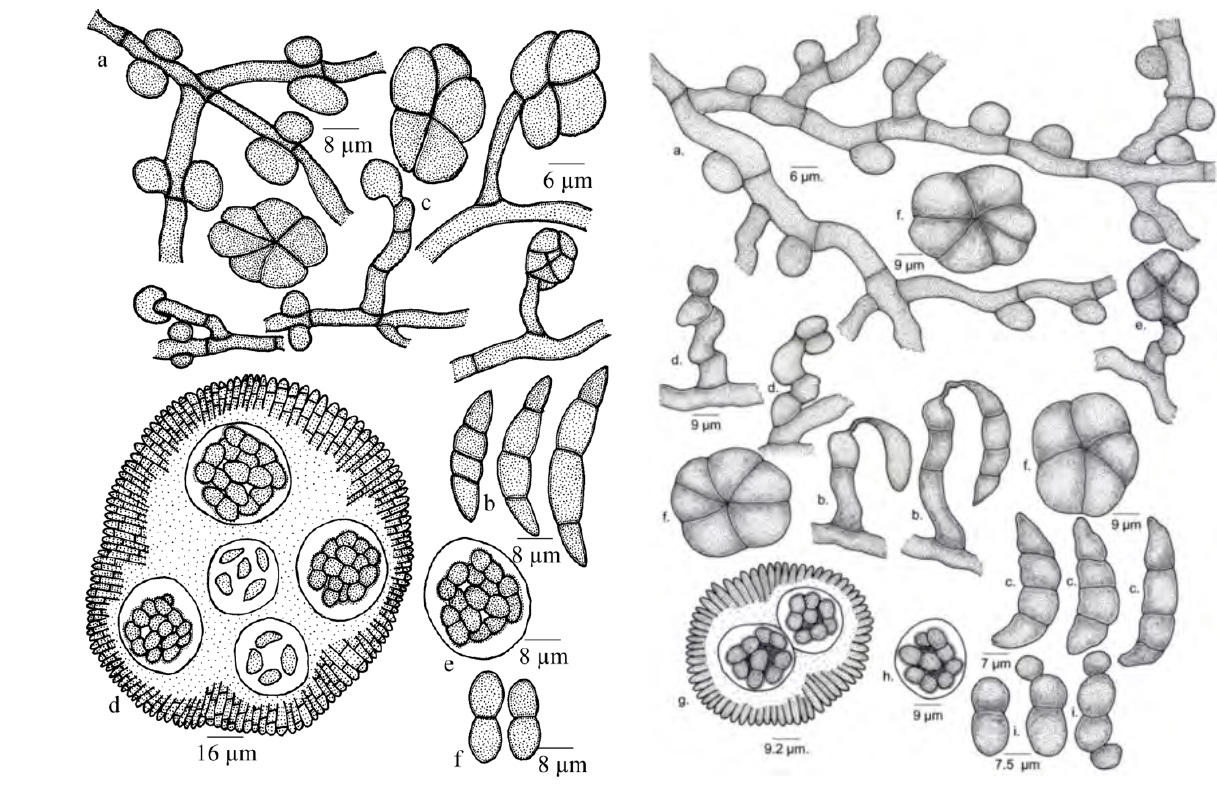
Figure 192. Schiffnerula lagerstroemiae a - Appressoriate mycelium; b - Conidiophores of Questieriella ; c - Conidia of Questieriella ; d - Conidiophores of Sarcinella , e. Sarcinella conidia on conidiophores; f - Conidia of Sarcinella ; g - Thyriotheicum; h - Ascus; i